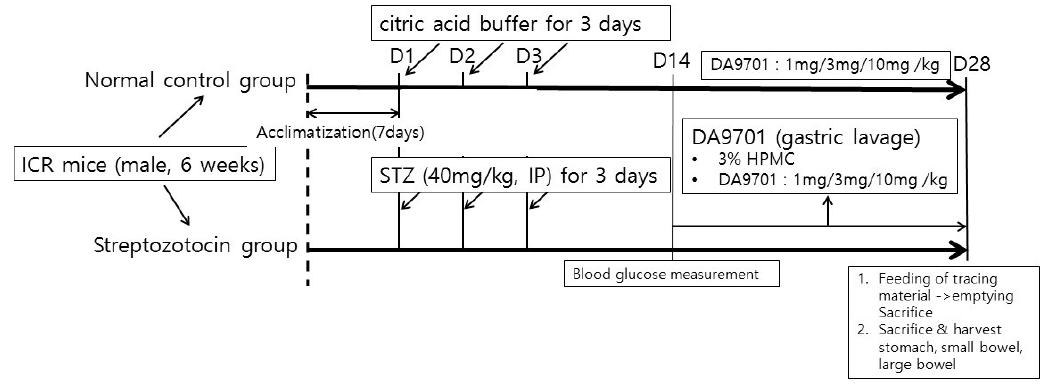
Figure 1. Schematic diagram of the experimental protocol. After the acclimatization phase of 7 days, streptozotocin was injected via intraperito- neal at a dose of 40 mg/kg for 3 days. The same volume of citric acid buffer was injected into normal control mice. Blood glucose level was measured after 14 days. Normal control and streptozotocin-induced mice were treated with DA-9701 in different doses (1, 3, and 10 mg/kg) for 14 days. On day 28, all mice were sacrificed, and gastrointestinal motility was assessed. 2.2. DA-9701 Treatment in Experimental Mice The STZ-induced diabetic mice were divided into four groups, each with 10 mice: STZ-induced diabetic mice treated with different doses of DA-9701 at 1, 3, and 10 mg/kg, and STZ-induced diabetic mice with the placebo treatment. DA-9701 was suspended and administered orally at different doses of 1, 3, and 10 mg/kg for 2 weeks, and the placebo group was orally administered 3% hydroxypropyl methylcellulose (HPMC) for 2 weeks (Figure 1). To show the maximum changes in GI muscular contractility according to the DA-9701 dose escalation, the normal control or STZ-induced diabetic mice were also treated at higher doses (>10 mg/kg; 30, 100, and 300 mg/kg). In this experiment, the mice were exposed to 1, 3, 10, 30, 100, and 300 mg/kg of DA-9701. 2.3. Assessment of GI Motility Using Isometric Contraction Measurement All studies were performed on normal or STZ mice after 2 weeks of treatment with DA-9701 or placebo. DA-9701 was given to the mice in different doses of 1, 3, 10, 30, 100, and 300 mg/kg. After 16 h of fasting, the mice were sacrificed. GI motility was evaluated by measuring isometric contractions in each segment of the bowel using circular muscle strips from the antrum, ileum, and proximal colon. From the sacrificed mice, 1–1.5 cm circular muscle strips of the antrum, ileum, and proximal colon were isolated and flushed with Krebs solution. The muscle strips were immediately placed in a 10 mL organ bath containing oxygenated (95% O 2 + 5% CO 2 ) Krebs solution at 37 °C. The distal end of the muscle segment was tied to a fixed mount and the tied proximal end was fixed to an iso- metric force-displacement transducer (FT-03, Grass-telefactor, Providence, RI, USA). Ten- sion was monitored using an isometric force transducer and an index of the longitudinal muscle response was recorded. The signal was analyzed using a digital recording system. The signals from the transducers were processed using Powerlab 4/30 and Chart 7.2 (AD Instruments, Bella Vista, Australia). The composition of Krebs solution was 10.1 mM glucose, 115.5 mM NaCl, 21.9 mM NaHCO 3 , 4.61 mM KCl, 1.14 mM NaH 2 PO 4 , 2.5 mM CaCl 2 , and 1.16 mM MgSO 4 .